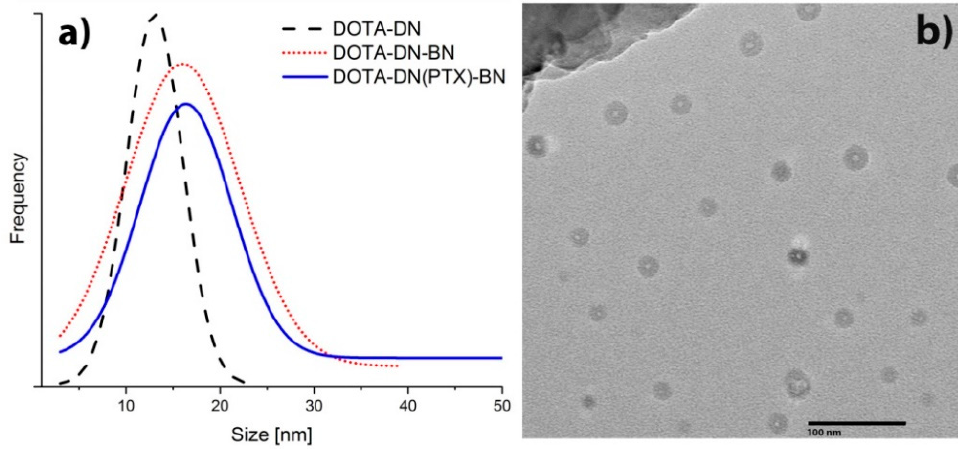
ff erent nanosystems ( b ) TEM of Figure 2. ( a ) Size distribution of the different nanosystems ( b ) TEM of DOTA-DN(PTX)-BN. Figure 2. ( a ) Size distribution of the di